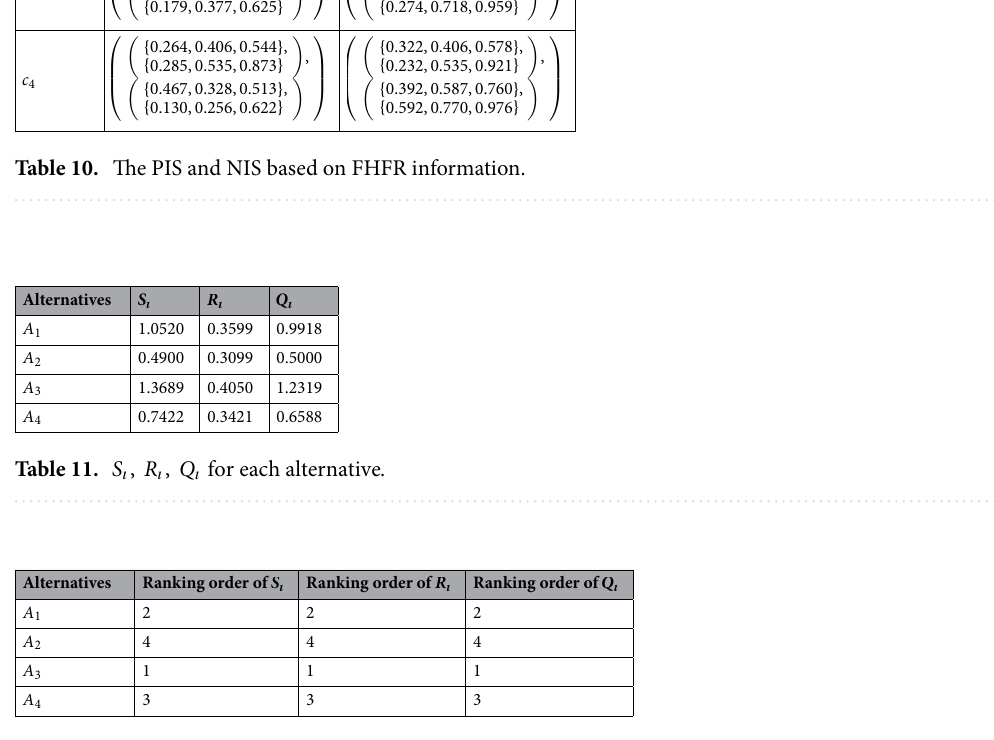
Table 12. Alternative ranking depending on S ı , R ı , and Q ı .